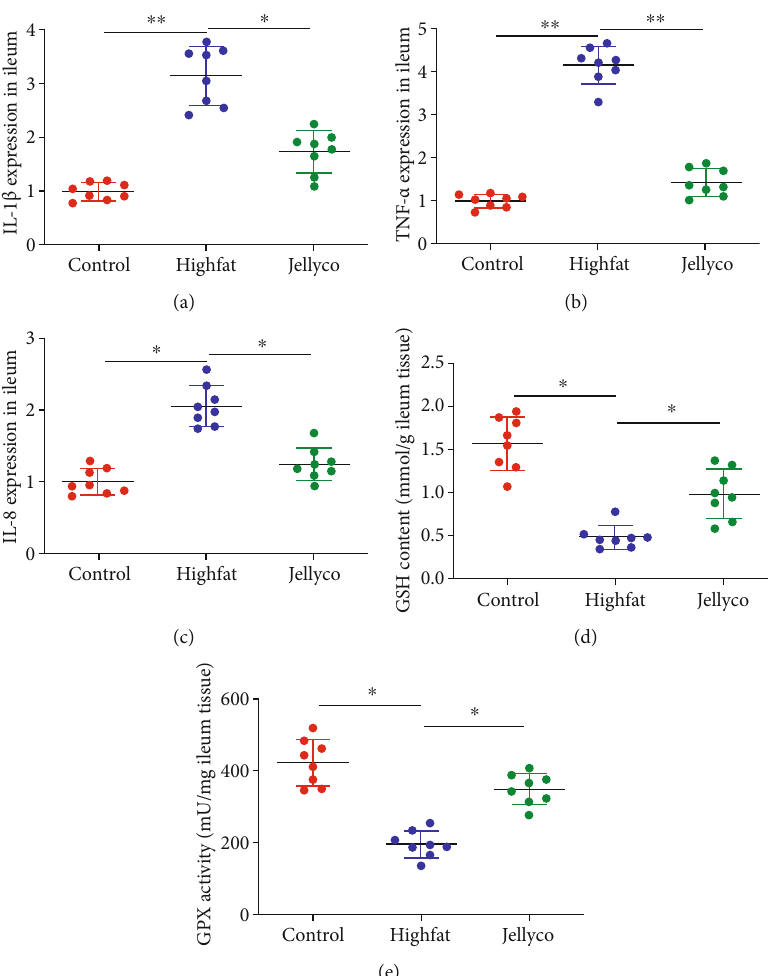
Figure 4: Jelly fi sh collagen hydrolysate alleviated in fl ammation and oxidative stress in ileum of high-fat diet-fed mice. Gene expression of IL-1 β (a), TNF- α (b), and IL-8 (c), (d) GSH content, and (e) GPX activity. Data are expressed as means ± SEM , n = 8 . ∗ P < 0 : 05 , ∗∗ P < 0 : 01